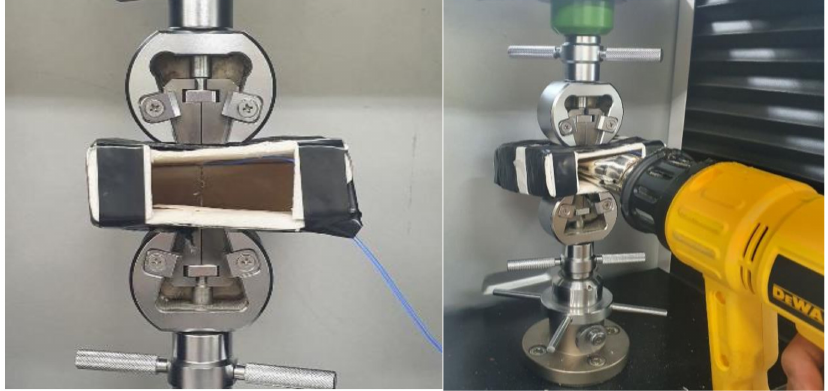
Figure 7. Test set-up to measure recovery stress of AR and CR